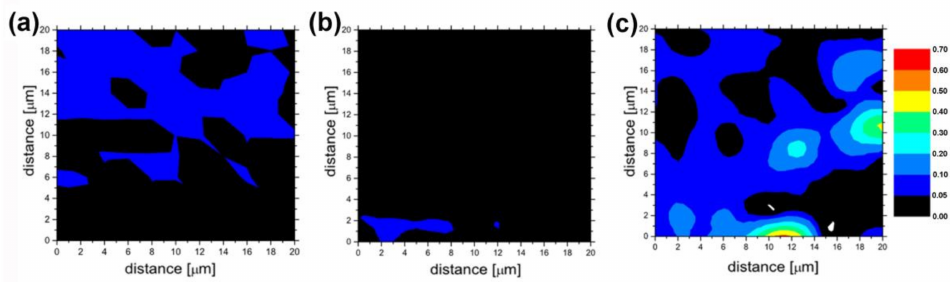
Figure 7. Maps of the ratio of the intensity of E 2 (high) and 662 cm − 1 mode: ( a ) 650 ◦ C, ( b ) 800 ◦ C, and ( c ) 1000 ◦ C.